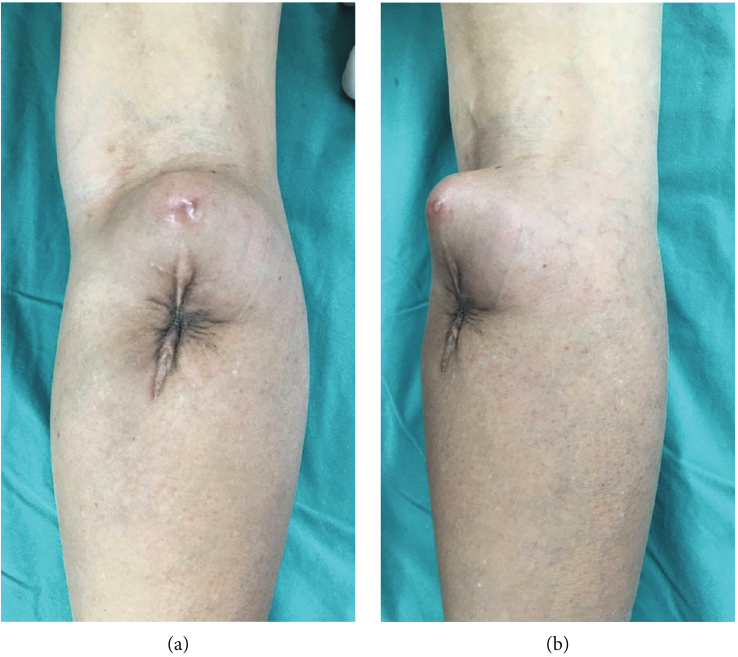
Figure 1: Physical examination fi ndings. (a) Posterior view. (b) Oblique